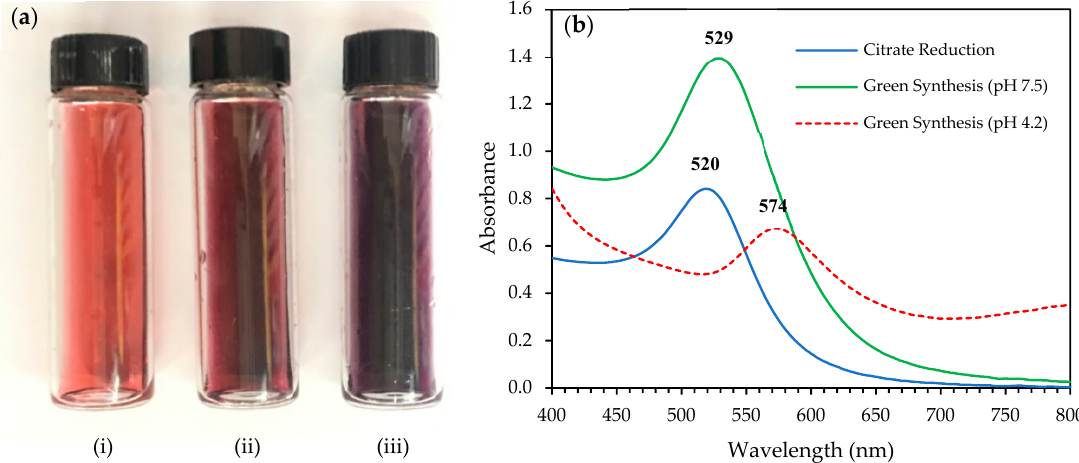
Figure 1. ( a ) Gold nanoparticles (AuNPs) solutions; i. red wine colour of AuNPs solution synthesised by the citrate reduction method, ii. deep red colour of AuNPs solution synthesised by the green synthesis method (pH 7.5), and iii. purple colour of AuNPs solution synthesised by the green synthesis method (pH 4.2). ( b ) UV-visible spectrum of synthesised AuNPs by respective methods with the scale of wavelength between 400 and 800 nm.